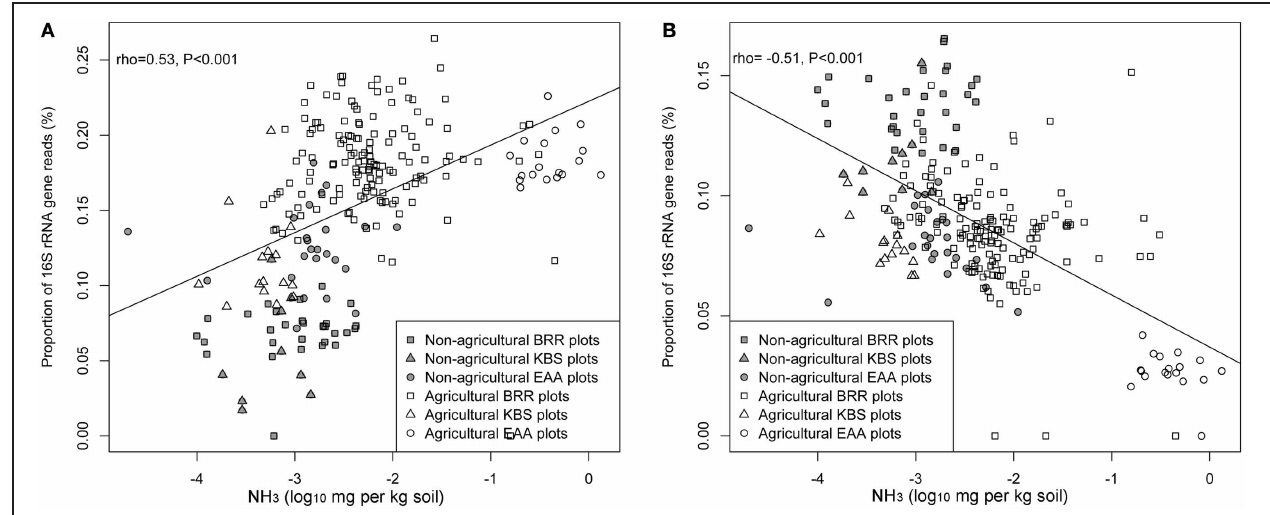
FIGURE 6 | Relationship between the proportion of Ca. Nitrososphaera 16S rRNA gene reads (%) and NH 3 concentration (A); Bradyrhizobium and NH 3 concentration (B) at three experimental sites. Proportion of 16S rRNA reads was normalized by arcsine square